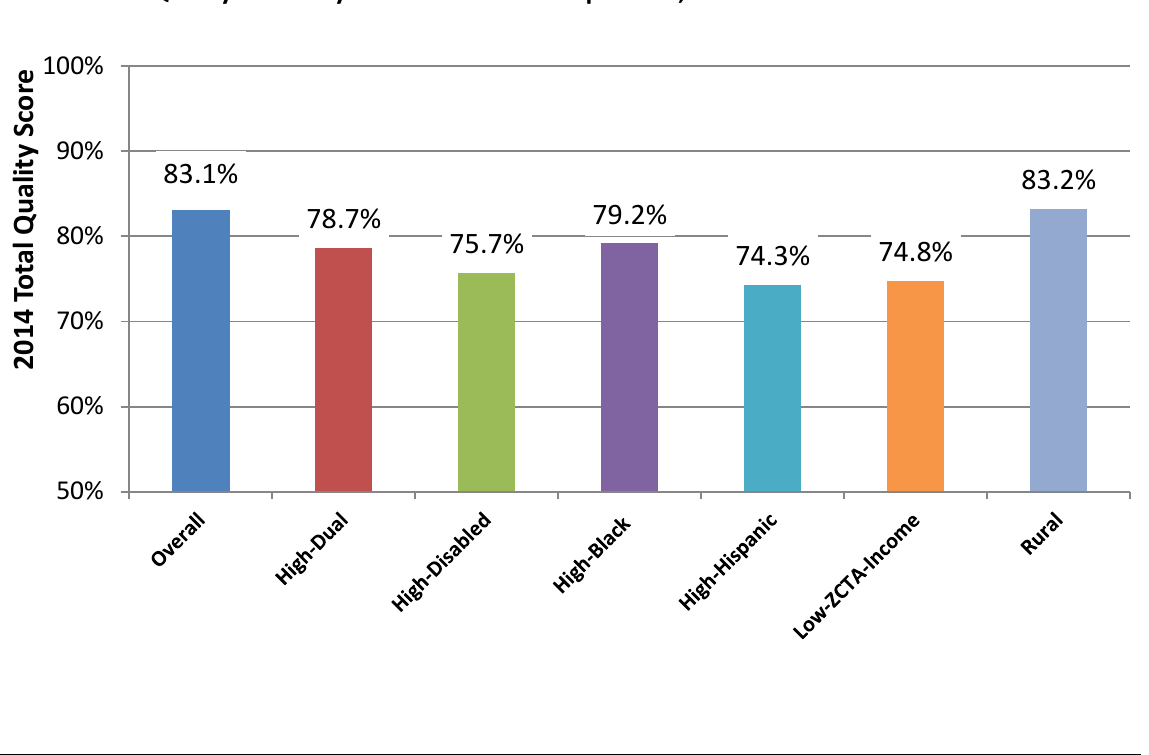
Figure 9.3: ACO Quality Scores by ACO Social Risk Composition,